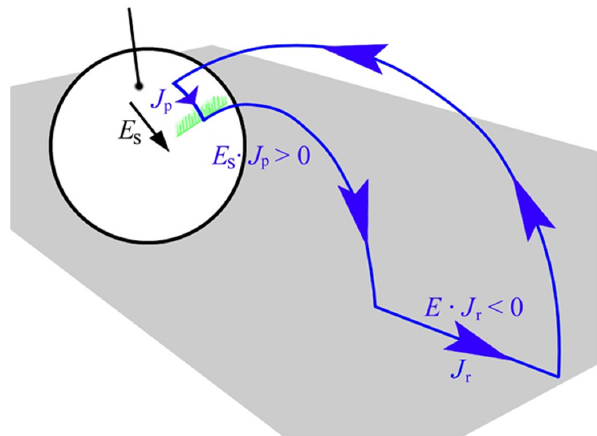
Fig. 13a. Bostrom’s azimuthal current loop. It is a sheet form that produces the auroral curtain.